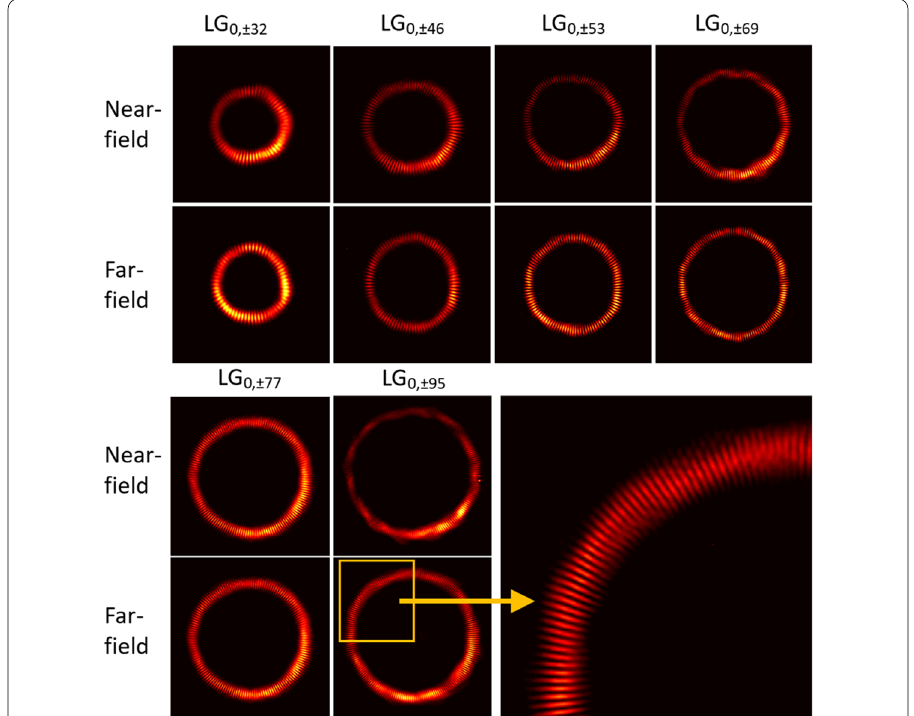
Fig. 6 Typical beam patterns obtained with different δ , when using lenses of focal length f 1 f 2 51.8 mm. The lowest and highest order of eigenmodes obtained are LG 0, = 5.6 mm) under the pump power of 1.20 =